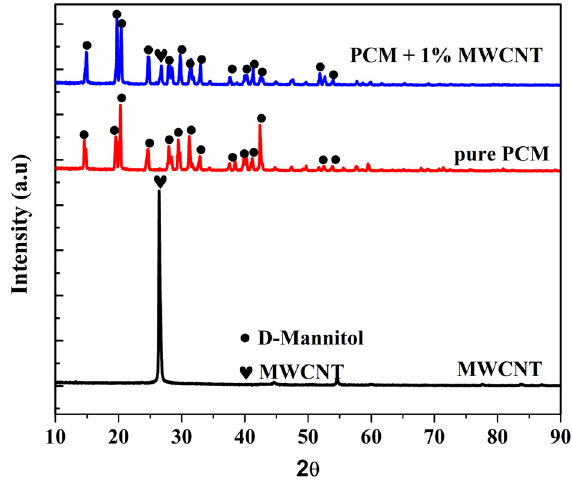
Figure 1. XRD peaks of pure PCM, MWCNT, and nano-enhanced PCM